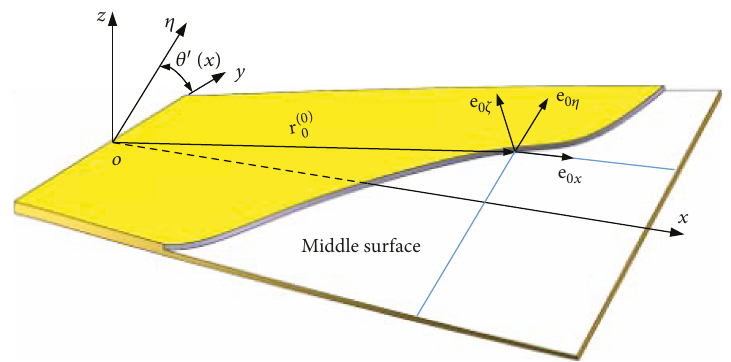
Figure 2: The dynamic coordinate system of the pretwisted rotating